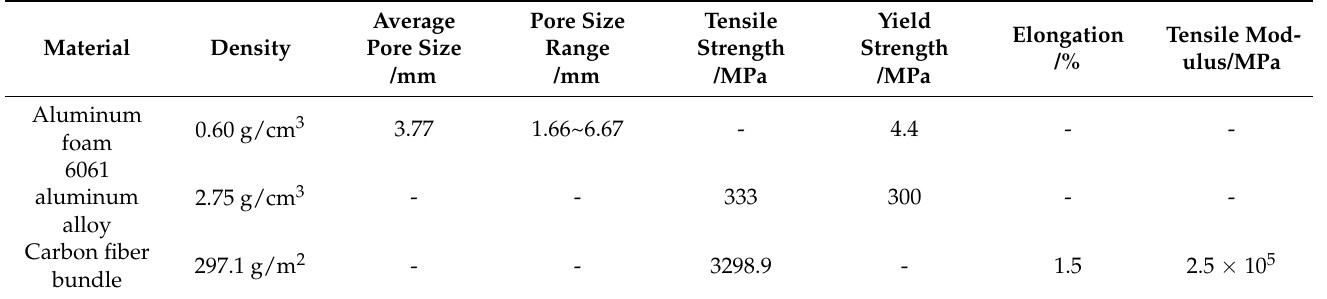
Table 1. Mechanical parameters of different materials in this study.